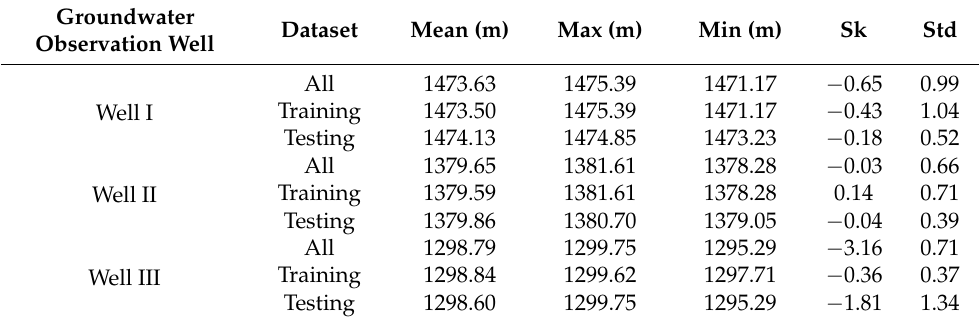
Table 1. The statistical parameters of the GWL for Wells I, II, and III.